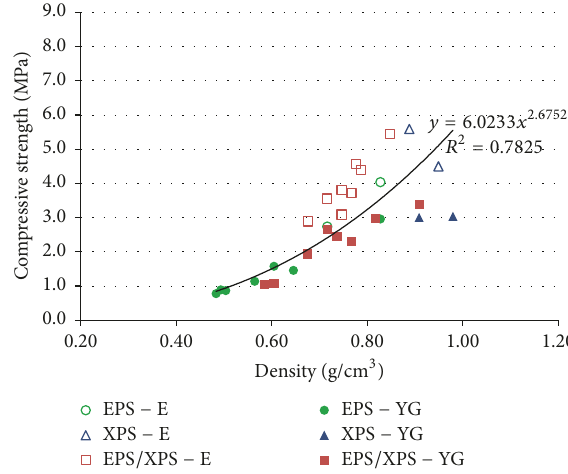
Figure 1: Relationship between compressive strength and the density of the compound.